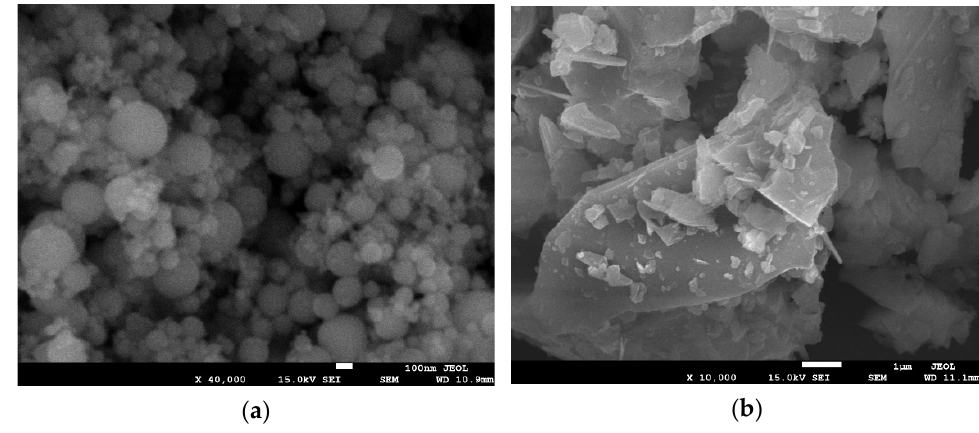
Figure 2. SEM images of silica fume and cement, ( a ) silica fume and ( b ) cement.